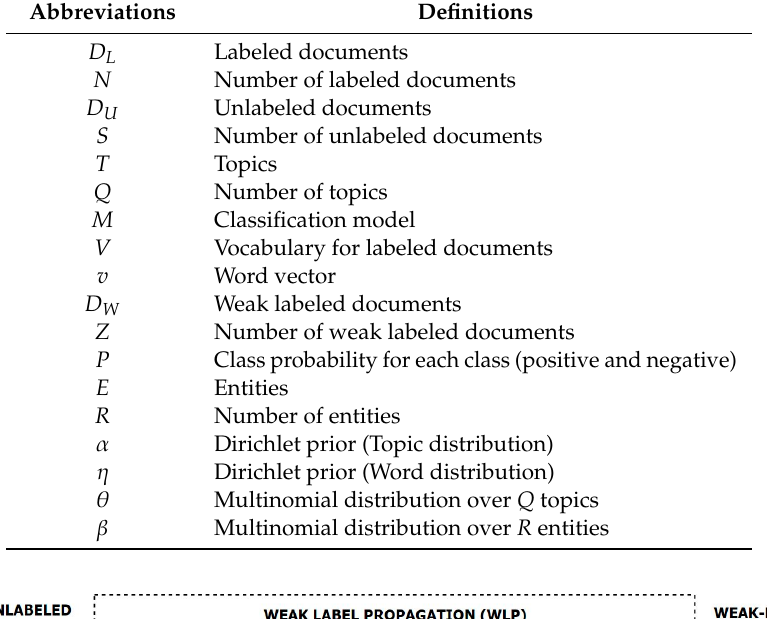
Table 1. List of abbreviations.